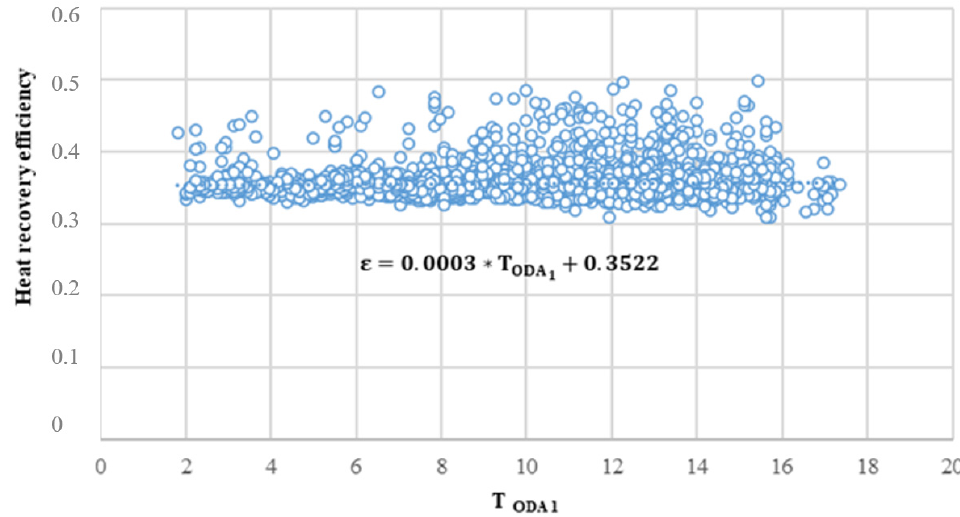
Figure 5. Heat Recovery Efficiency versus Outside Temperature.